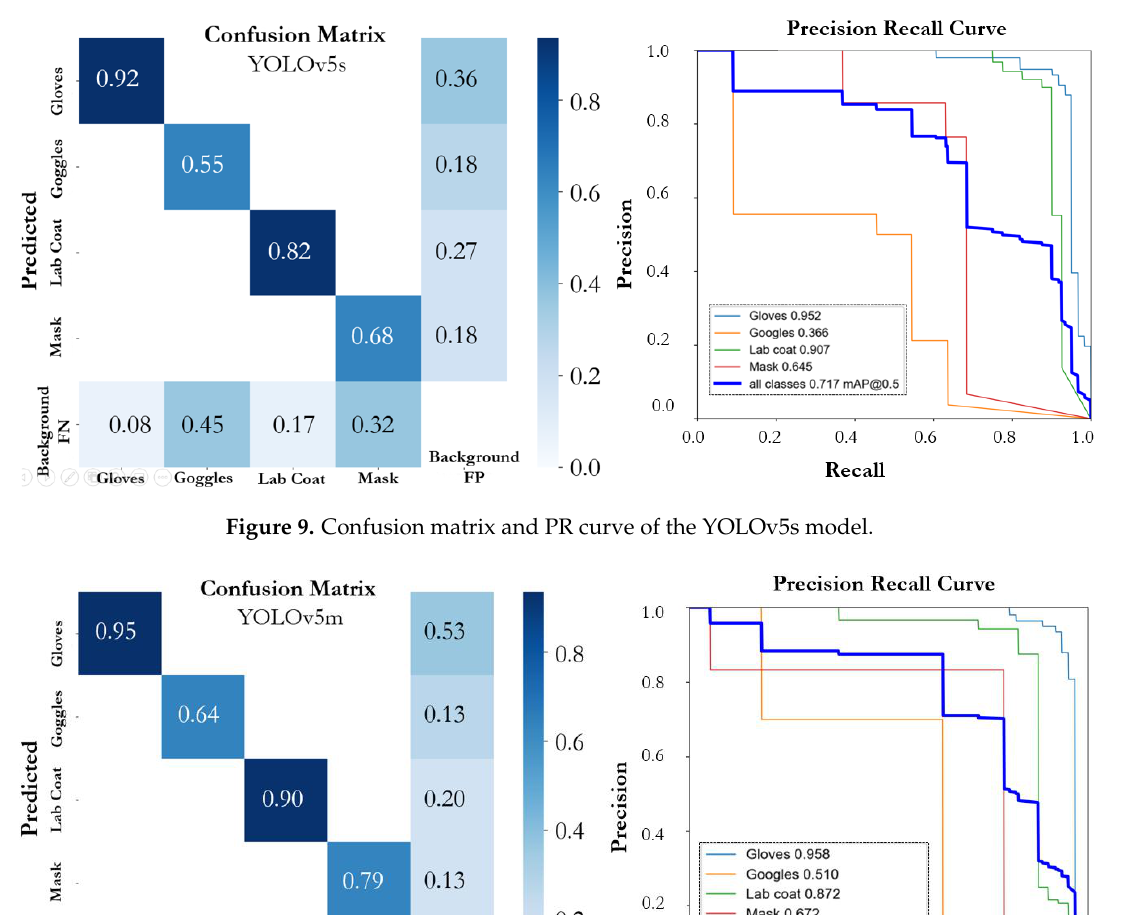
Figure 8. Confusion matrix and PR curve of the YOLOv5n model.